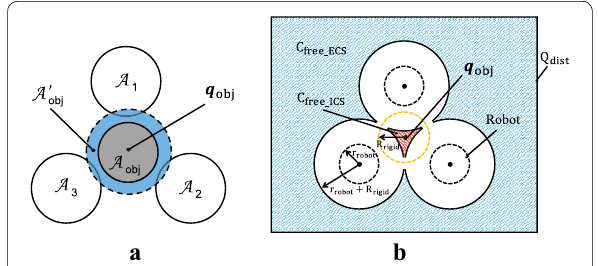
Fig. 4 Definition of symbols. a Real space and b configuration